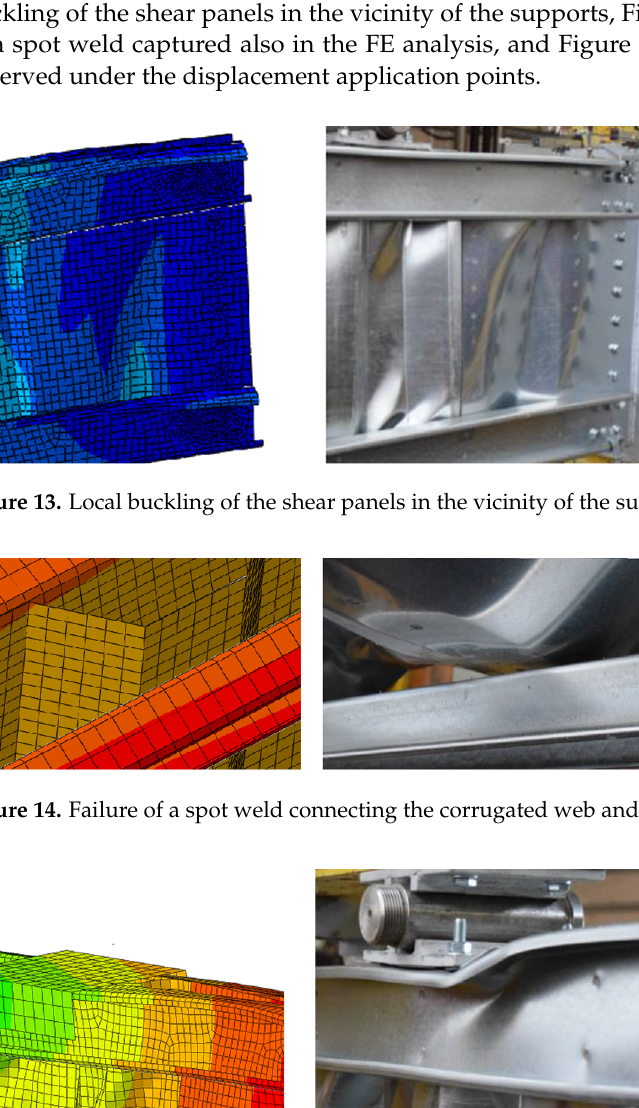
Figure 16. Force–displacement curves for the calibrated FE model and the experiment. 4. Parametric Numerical Study This parametric study was conducted to study the influence of different parameters that have a major effect on the performance of the built-up cold-formed steel beam. The influence of different components was analyzed through the parametric study consider- ing beams with three lengths, i.e., (1) 6000 mm, (2) 7500 mm, and (3) 9000 mm, with and without web openings. The lengths of the beams considered in the parametric study were common for multi-story buildings due to their structural efficiency, chosen based on func- tionality criteria for the building (e.g., minimum dimensions of the parking lots). The parameters are presented in Table 1. The thicknesses of the steel sheets and the profiles sections were chosen considering the usual sections that can be found on the mar- ket.